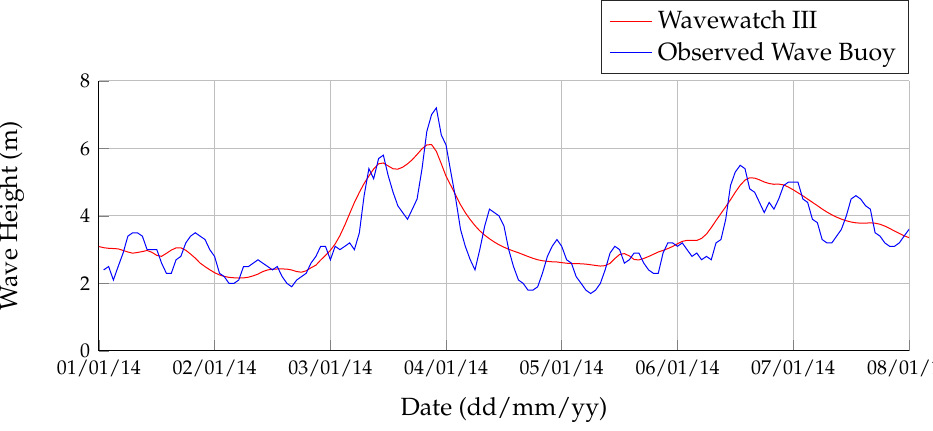
Figure 5. Observed wave height and modelled wave height for Aberporth buoy